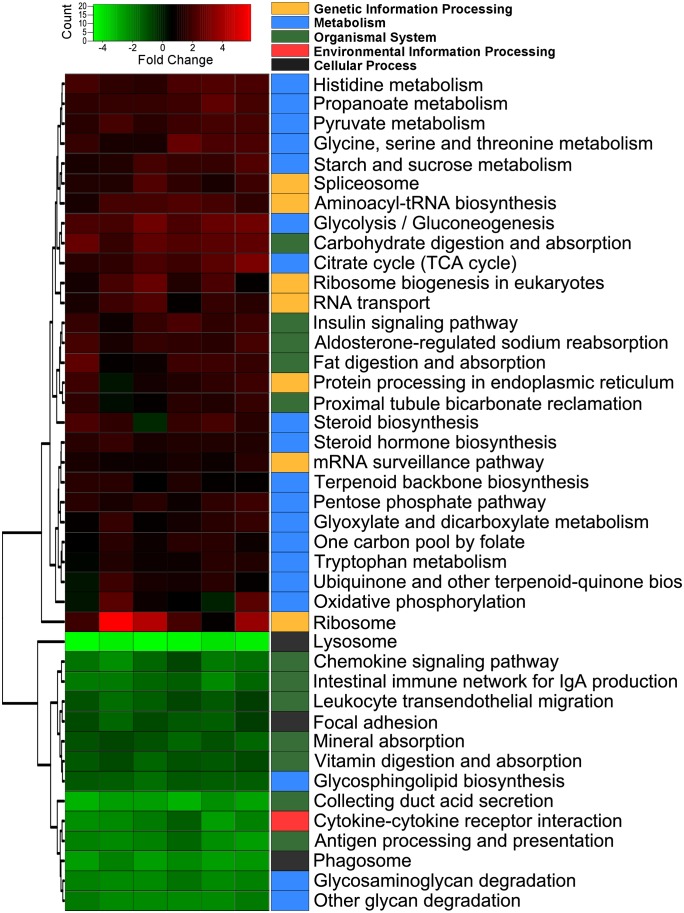
Heatmap plotting GAGE results from the 1d test in the intestine of 10 g parr compared to 2.5 g fry fed the basal unsupplemented (low phospholipid) diet.All gene-sets with q < 0.05 are shown. Pathways are colour-coded based on the broad classification category (Kegg). Further details are provided in S2 Table. Data were plotted using heatmap.2 [37] and rows were clustered according to Euclidean distance.